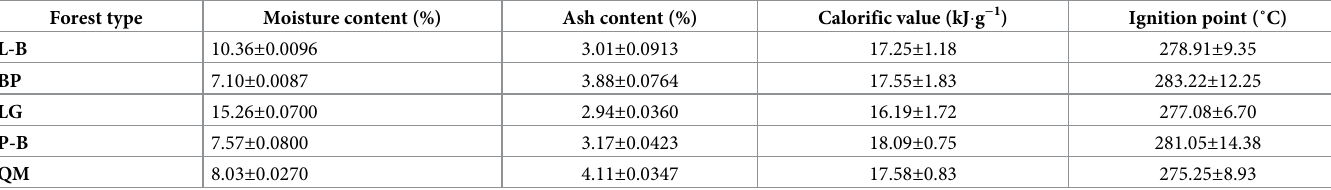
Table 2. Physical and chemical properties of dead combustibles. Forest